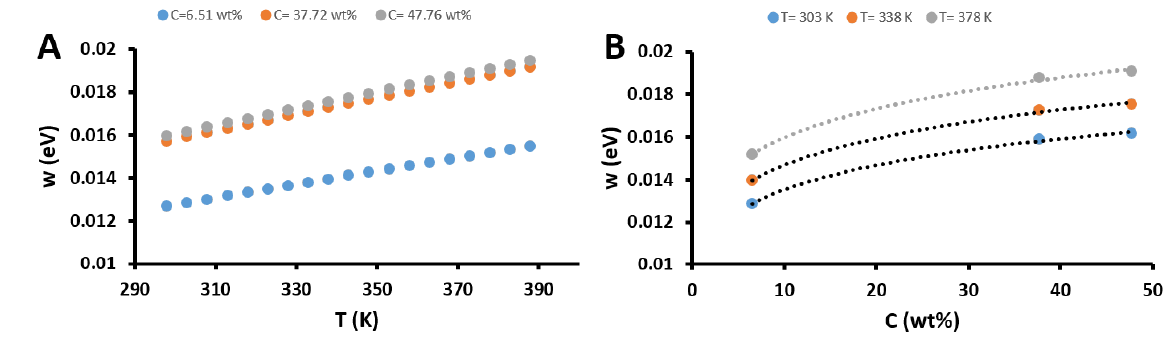
Figure 6. Activation energy of nanocomposite samples as a function of ( A ) temperatures; ( B ) MWCNT concentration at three selected temperatures: 303, 338, and 378 K.